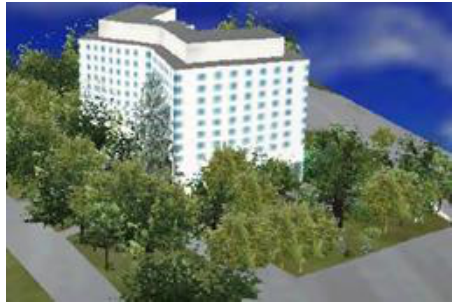
Figure 2. Image-based modelling Hotel Hilton –